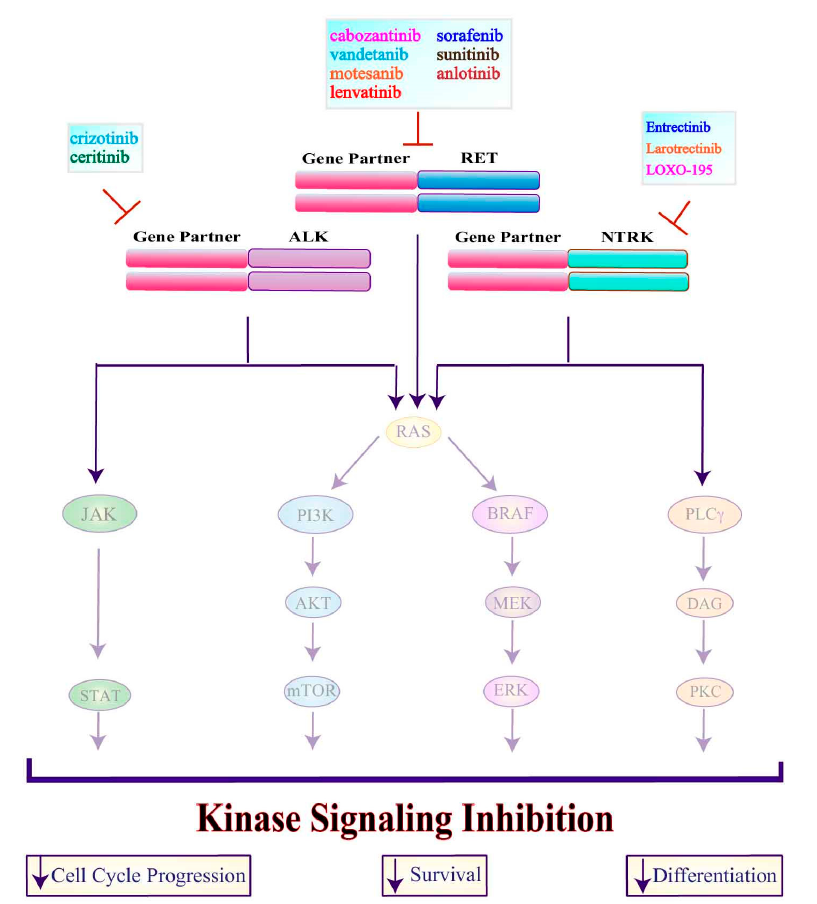
Figure 5. Mechanism of action of ALK, NTRK and RET fusion proteins inhibitors. Compounds targeting the ALK, NTRK and RET fusion proteins are listed in boxes. These drugs inhibit multiple cellular processes blocking cell cycle progression, survival and di ff erentiation. ALK, anaplastic lymphoma kinase; NTRK, neurotropic tropomyosin receptor kinase; RET, rearranged during transfection; RAS, Rat Sarcoma; JAK, Janus kinase; STAT, signal transducers and activators of transcription; PI3K, phosphoinositide 3-kinase; AKT, V-Akt Murine Thymoma Viral Oncogene Homolog; mTOR, Mammalian Target of Rapamycin; BRAF, B-Raf proto-oncogene; MEK, Mitogen-Activated Protein Kinase; ERK, Extracellular Signal-Regulated Kinase; PLC γ , phospholipase C- γ ; DAG, Diacylglycerol; PKC, protein kinase C.